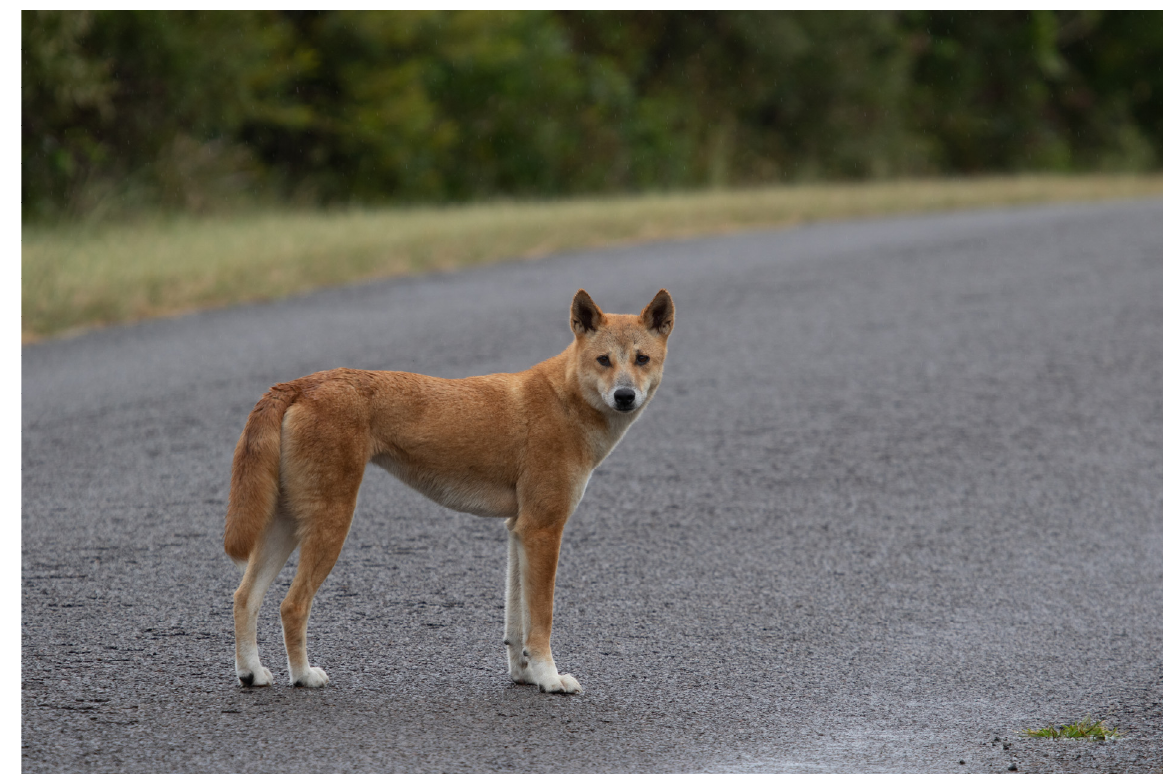
Figure 1. A dingo ( Canis dingo ). The photograph was taken in the Hunter Valley region of eastern New South Wales in 2022. Credit: Bradley Smith.